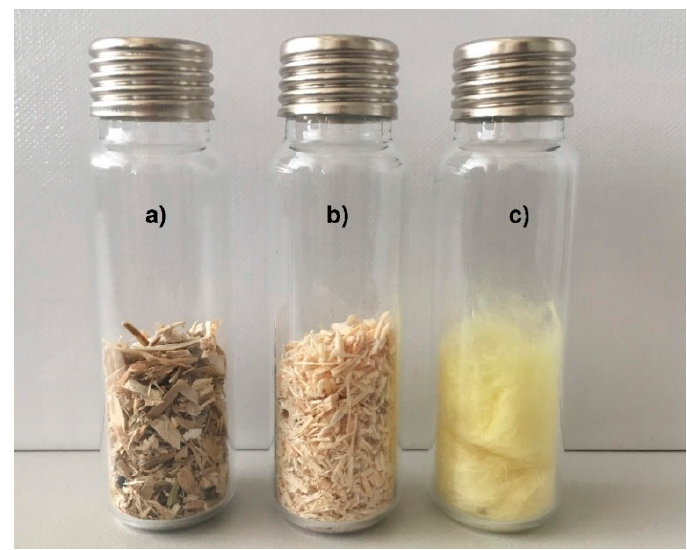
Figure 2. Samples closed in vials ready for GC-MS analysis: ( a ) short-cut rapeseed; ( b ) short-cut woodchips; ( c ) mineral wool.